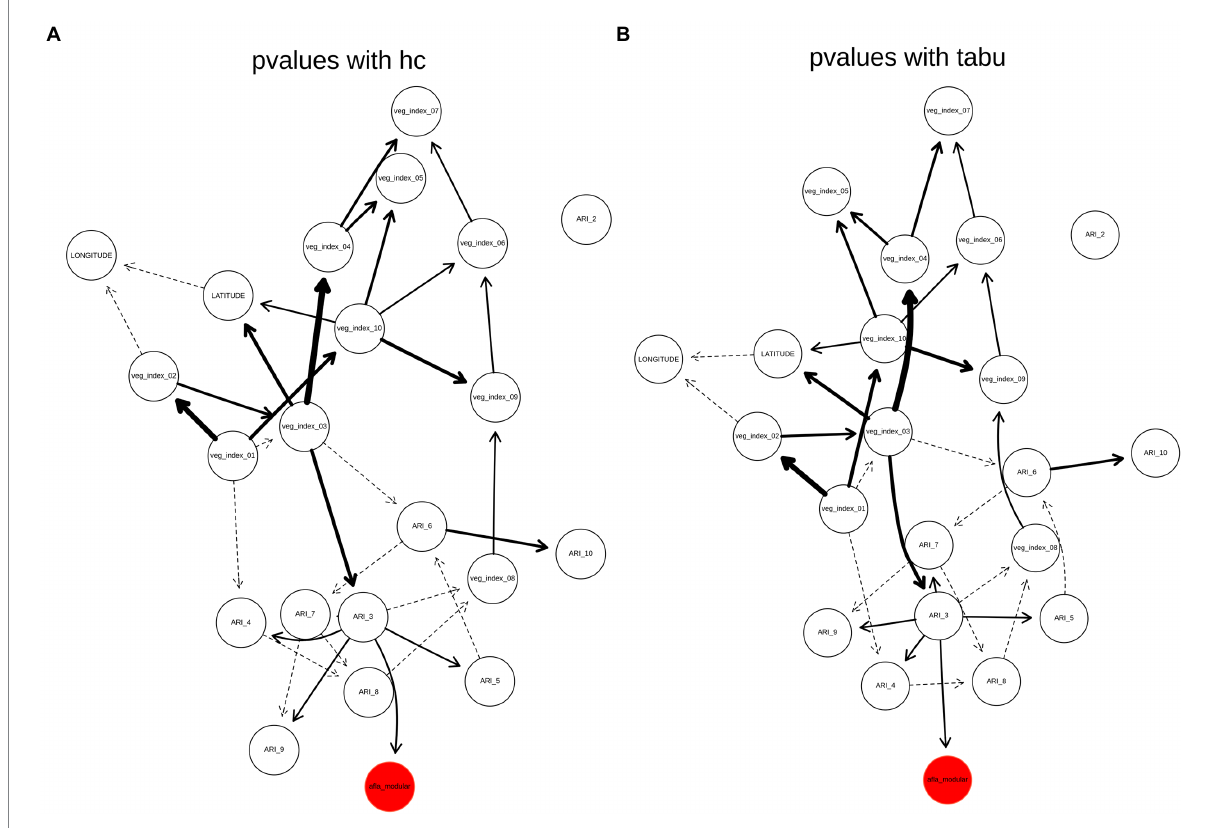
FIGURE 4 Weighted BN of AFL created by using (A) , hill-climbing (HC) and (B) , TABU algorithms. In the networks highlighted in red is the AFL node and in bold are significant interaction, thickness of the arrow represents strength of the interaction.